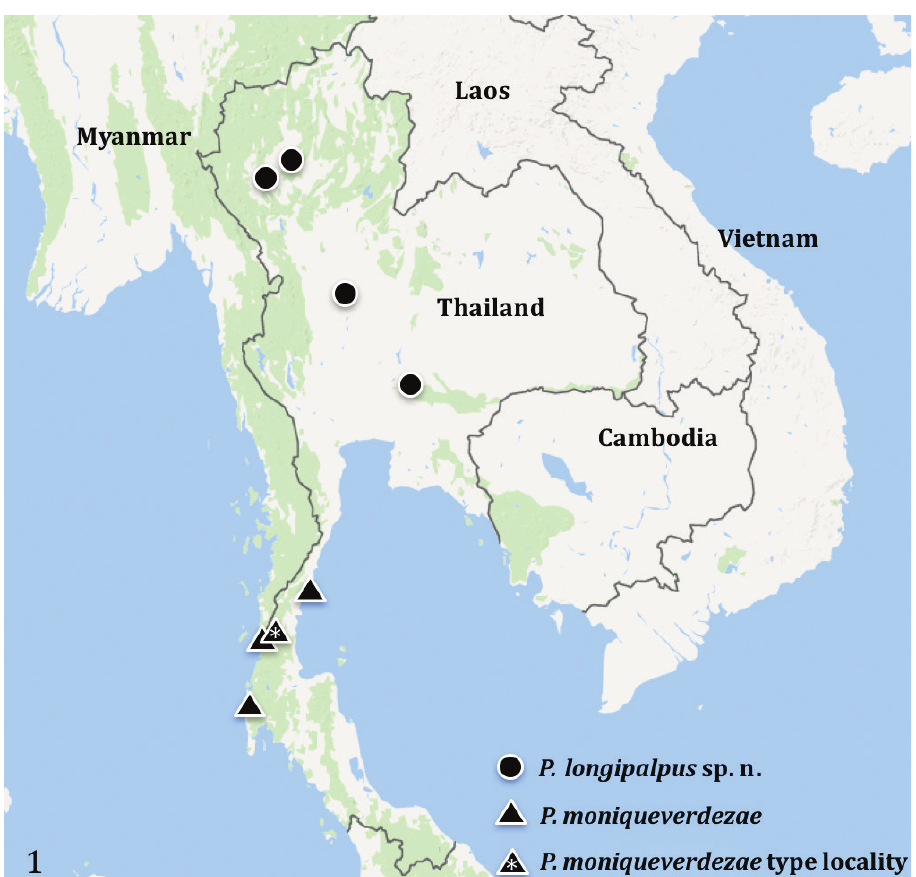
Figure 1. Distribution records of Phlogiellus in Thailand: P. moniqueverdezae Nunn et al., 2016 from Ra- nong province, and P. longipalpus sp. n. (Kamphaengphet, Lamphun, Lampang and Saraburi